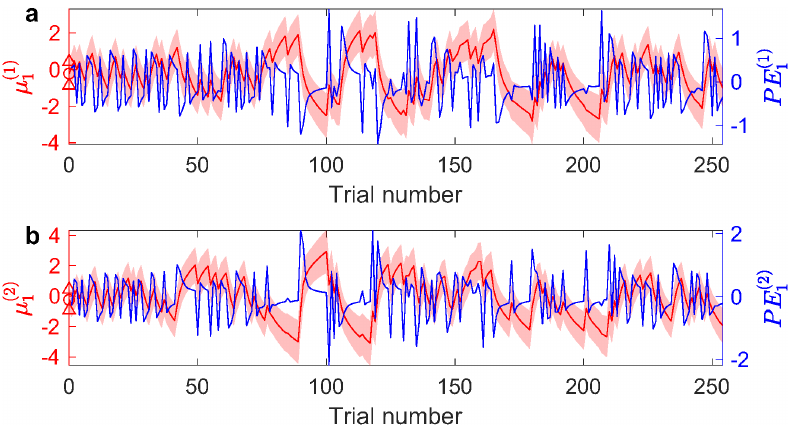
Figure 5. Temporal dynamics of the tendency µ ( 1 ) evolution of µ , the first component of µ 1 ( 1 ) prediction error PE is shown in blue. ( b ) The evolution of µ 1 shown in red. The time-varying trajectory of the prediction error PE shaded area represents the uncertainty of each quantity (i.e., µ markers , represent the priors on the standard deviation and mean of each (cid:52) ◦